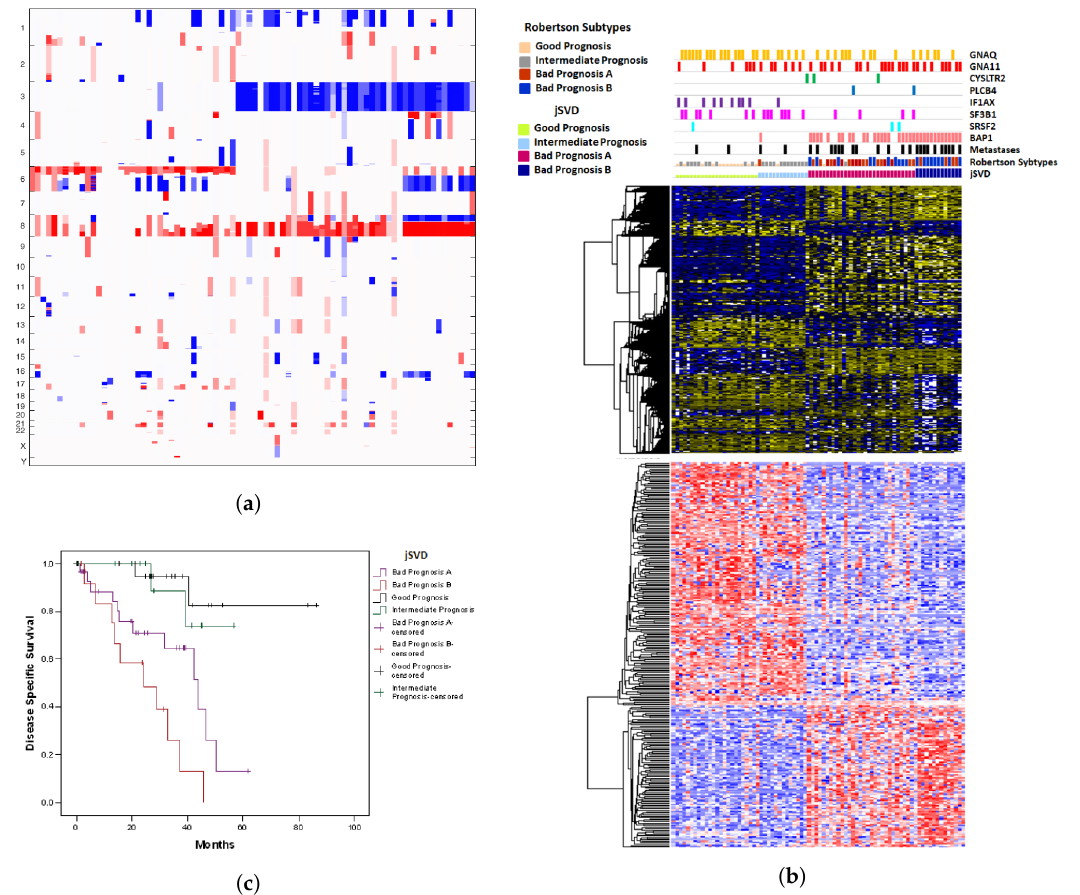
Figure 1. ( a ) Copy Number variation plot for the clusterings obtained by jSVD; columns = samples, rows = chromosomes. ( b ) Somatic mutation, transcriptome and methylome data for the clusterings obtained by jSVD; columns = samples, rows = genes. ( c ) Kaplan Meyer survival curves for the clusterings obtained by jSVD; y -axis = ratio of patients surviving, x -axis: time in months. Gains (red or yellow) and losses (blue) are indicated by conventional color